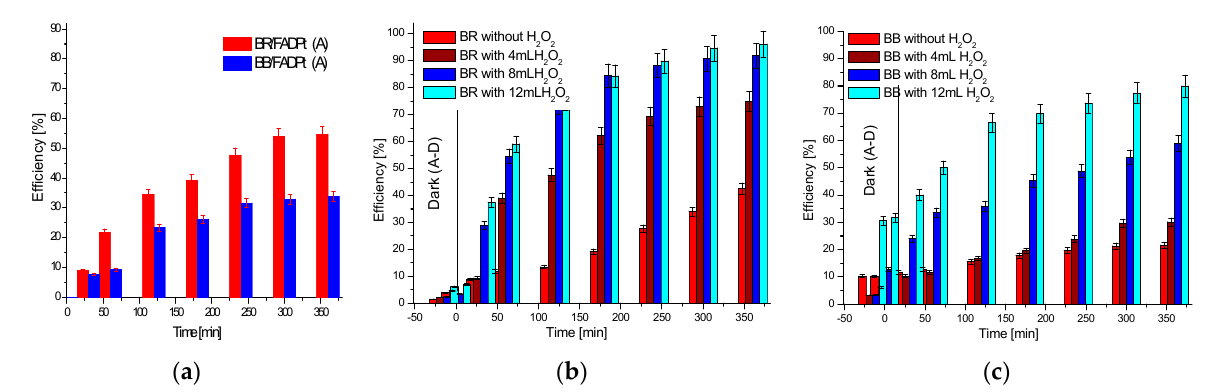
Figure 10. The efficiency of BB and BR dye removal: ( a ) by adsorption; ( b , c ) by photocatalysis.